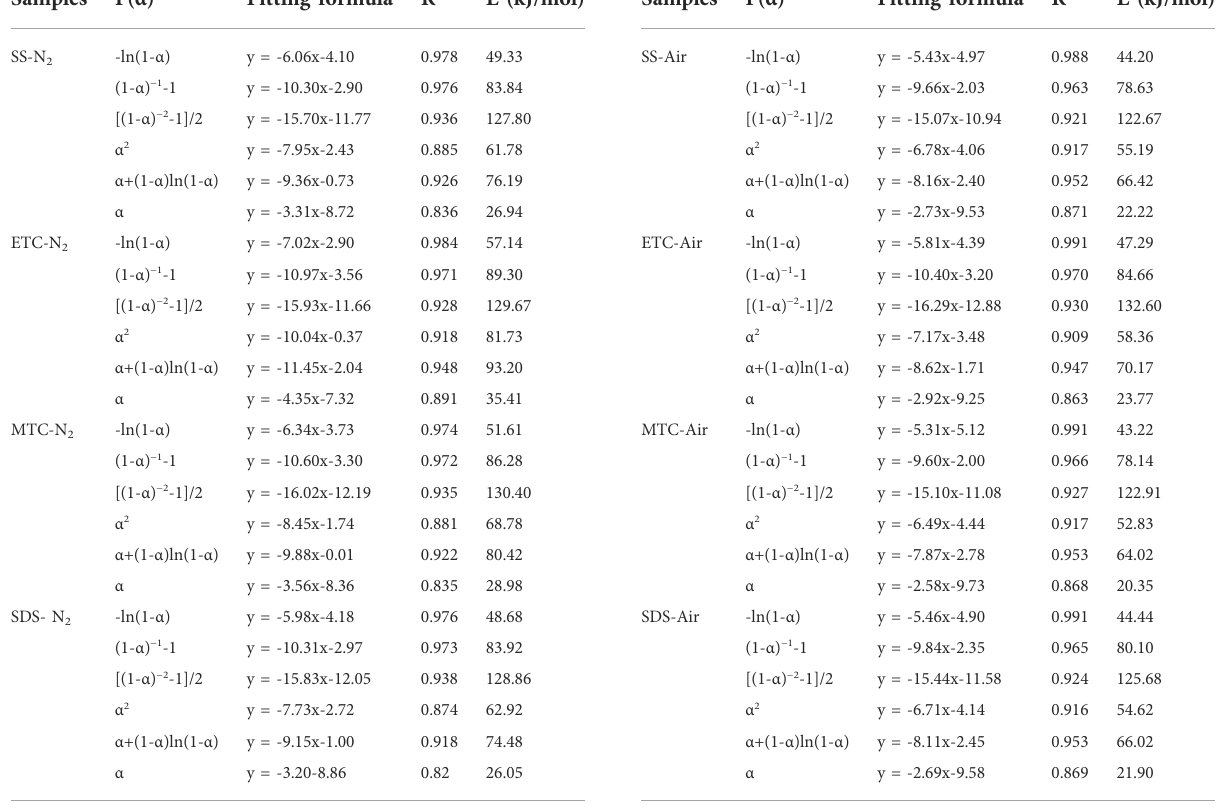
TABLE 3 Pyrolysis kinetic parameters of different SSsamples based on Coats-Redfern method. Samples